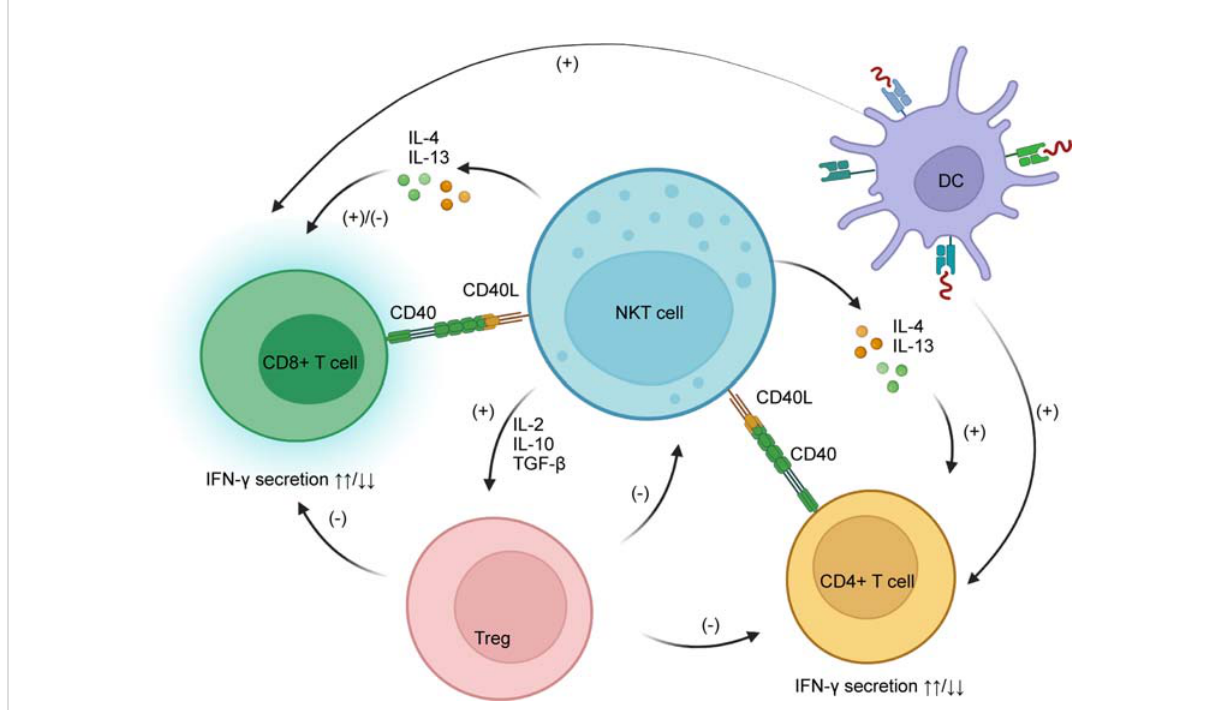
FIGURE 3 NKT cells interact with CD8+ and CD4+ T cells through CD40/CD40L and secretion of IL-4 and IL-13. The main functions of NKT cells on CD4+ T cells are stimulatory, while on CD8+ T cells they are both stimulatory and inhibitory, as NKT cells can harass their chemotaxis. NKT cells potentiate Tregs by secreting IL-2, IL-10, and TGF- b ; Tregs have a negative impact on CD8+ and CD4+ T cells as well as NKT cells. IL, interleukin; TGF, tumor growth factor; Treg, regulatory T